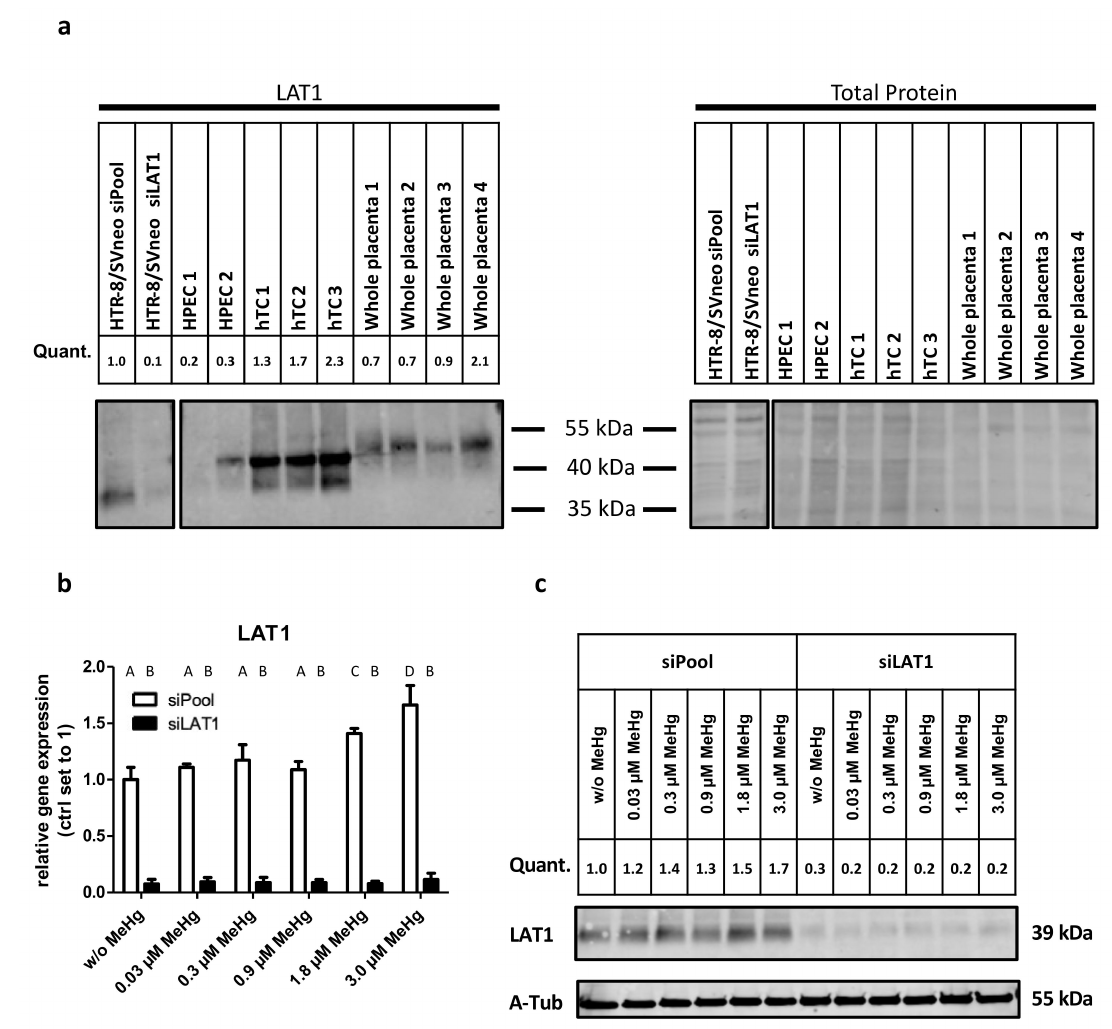
Figure 1. L-type amino acid transporter (LAT)1 protein expression in different types of placental cells and LAT1 knockdown verification in HTR-8/SVneo cells. ( a ) LAT1 protein expression in first trimester placental cell line HTR-8/SVneo in comparison to human primary placental endothelial cells (HPEC), human primary trophoblast cells (HPECs, hTCs), and whole placenta. LAT1 mRNA levels, analyzed by ( b ) qPCR and ( c ) protein levels determined by immunoblot in control (siPool) or siRNA-mediated LAT1-knockdown cells (siLAT1) treated with methylmercury (MeHg). LAT1 quantification (Quant.) was normalized to total protein ( a ) or alpha-tubulin (A-Tub) ( c ). Gene expression data represent mean values ± SD from three independent experiments, each performed in triplicate. Letters A–D denote homogeneous subgroups derived from one-way ANOVA and Student–Newman–Keuls (S–N–K) post hoc test ( p <